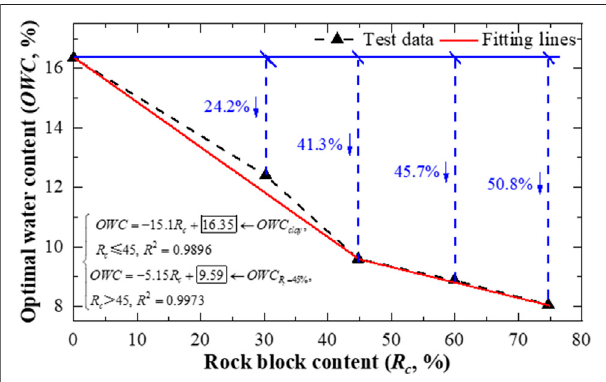
FIGURE 4 | Variation of the optimal water content of graded coarse- grained fi llers with different rock block